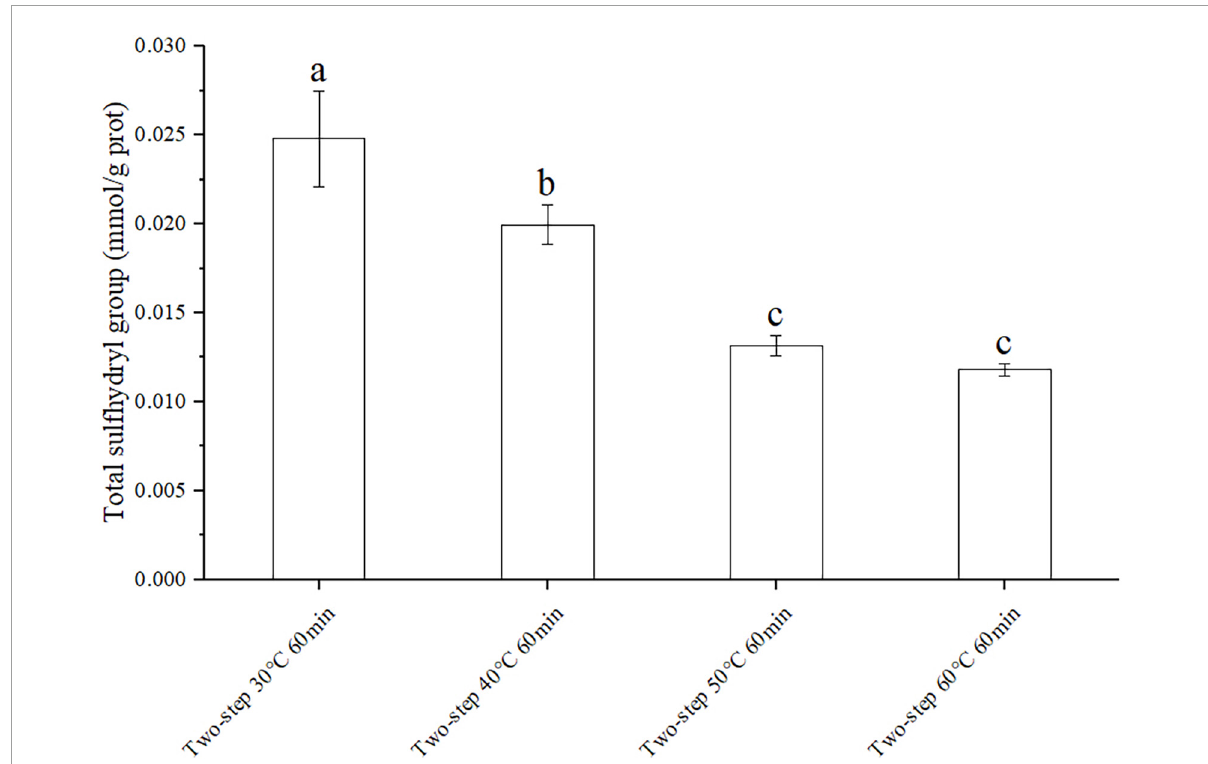
FIGURE4 Changes of total sulfhydryl group under different heating conditions. Different letters showed the significant changes ( p < 0.05). Data were obtained as the mean ± standard deviation ( n = 5).